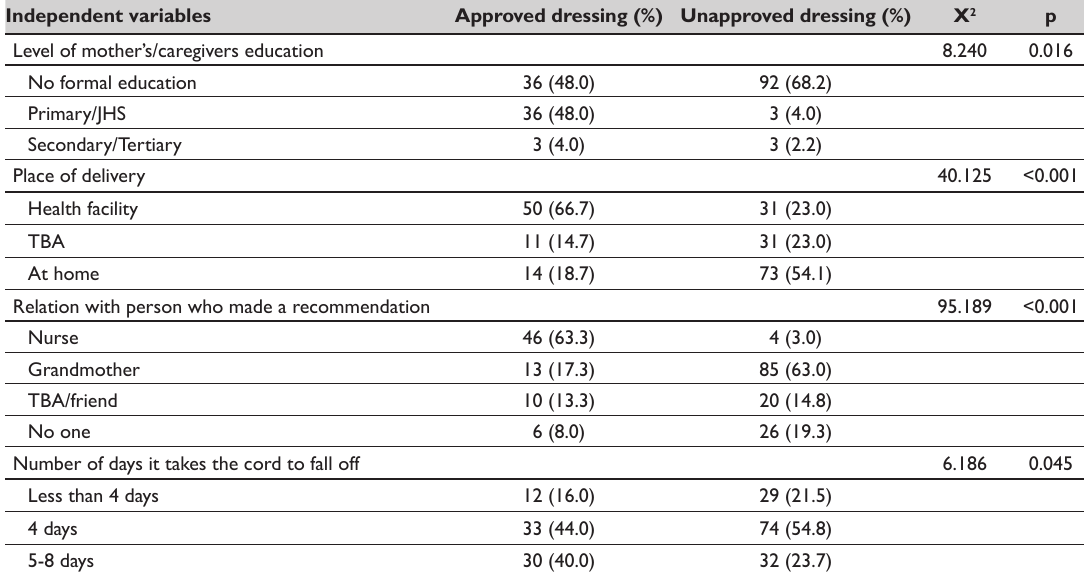
Table 3: Bivariate analysis on the effect of the independent variables on the type of dressing used on the umbilical cord of